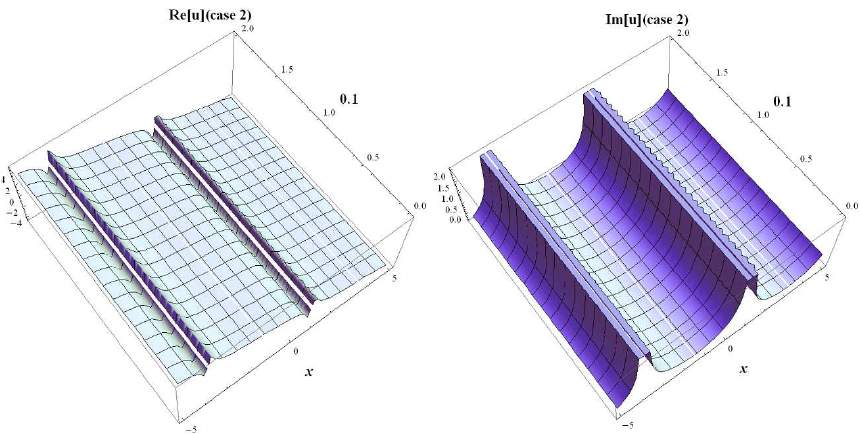
Fig. 2 The 3D and 2D surfaces of the solution for (17) for suitable